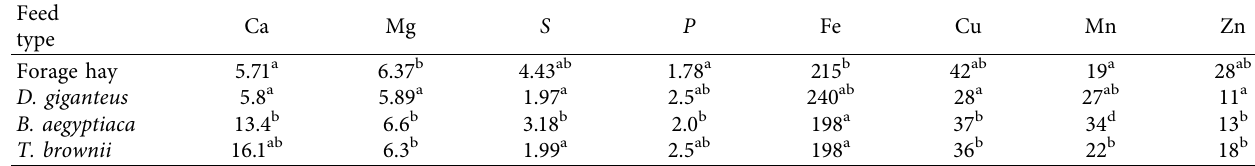
Table 4: Concentration of macro- (g/kg DM) and microminerals (mg/kg DM) in fodder tree leaves.